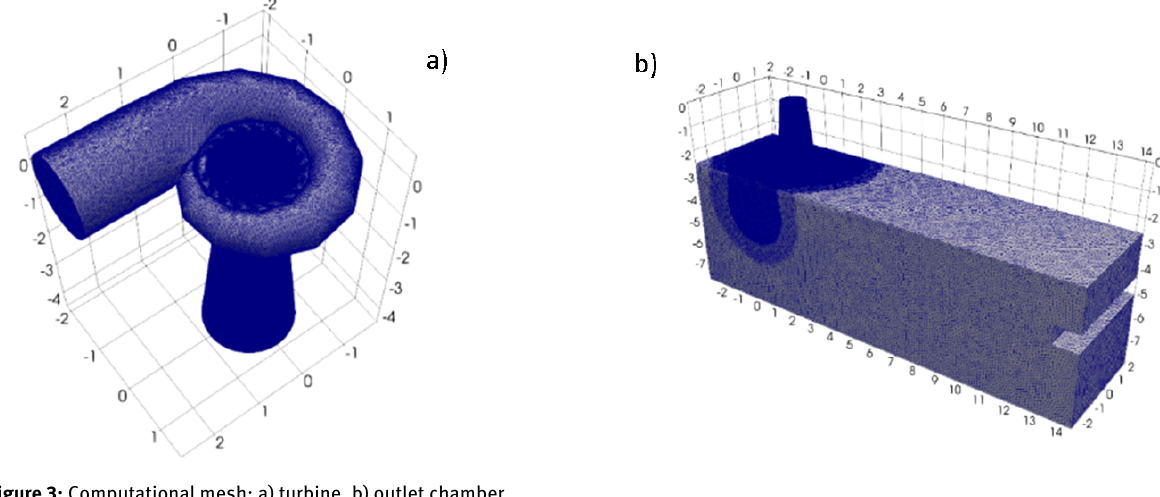
Figure 3: Computational mesh: a) turbine, b) outlet chamber